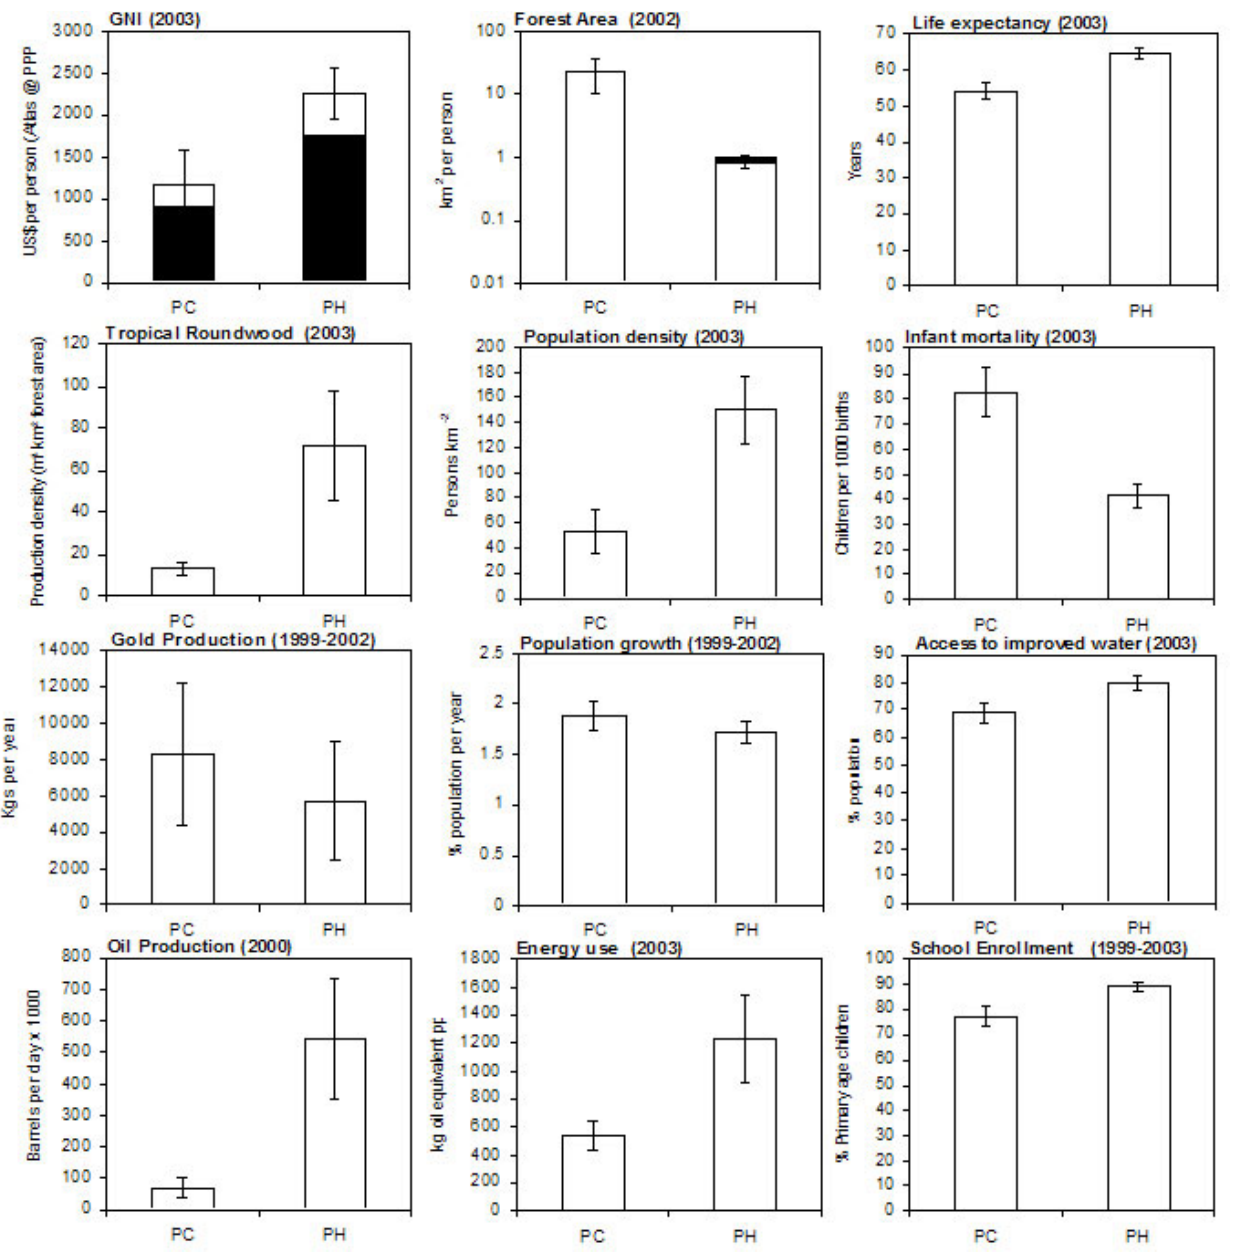
Fig. 3. A cross section of production and development indicators averaged across tropical forest countries as listed in Table 2 and according to dominance by Precambrian (PC) and Phanerozoic (PH) terranes. In the case of Brazil, state-municipio values were assigned based on overlap with PC or PH geological province. Data sources: FAO 2004, INEGI 2004, USGS 2004, World Bank 2005. Error bars represent standard errors. Filled bars in Forest Area and GNI averages for PH countries depict averages with Pacific and Caribbean islands